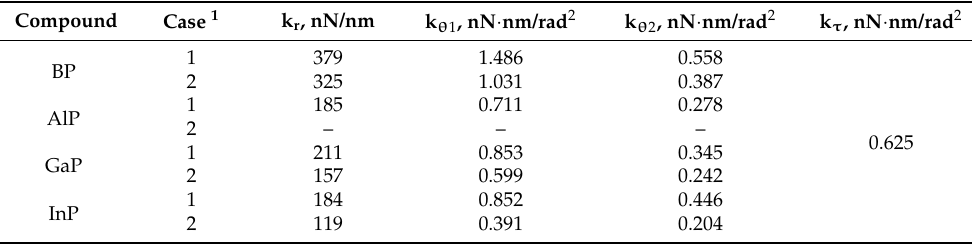
Table 3. k r , k θ and k τ force field constants for phosphide nanostructures. Compound Case 1